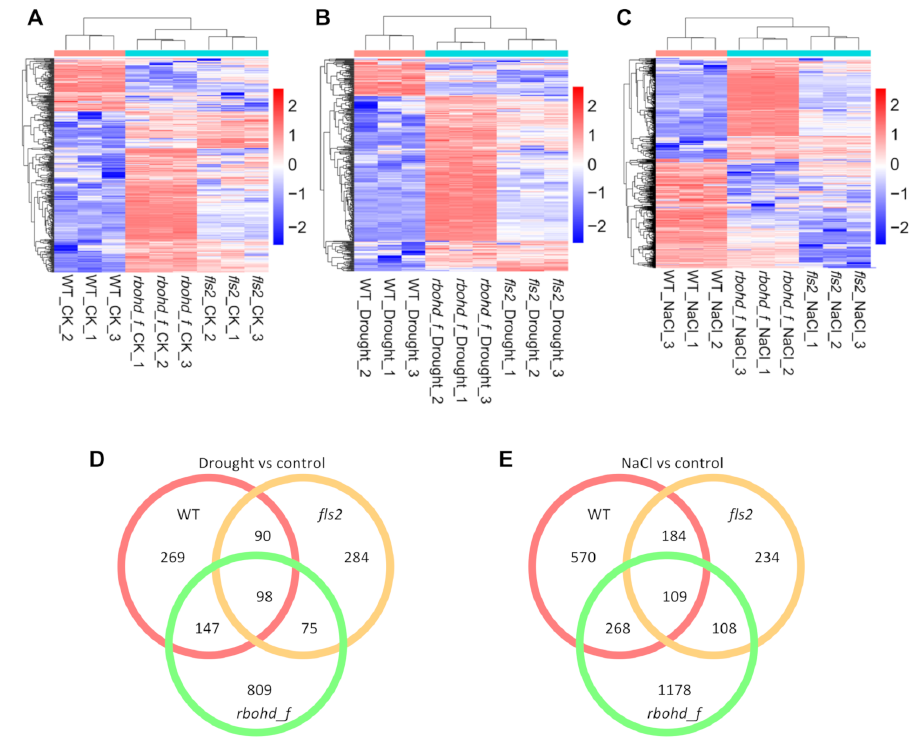
Figure 2. Heatmap and Venn analysis of DEGs under drought and salt conditions. ( A – C ) The heatmap analysis of the expression of DEGs. The number of suffix of sample name represents 1–3 repetitions. The screening criteria were fold change > 2 and p -value < 0.05. Red indicates gene up-regulation, blue indicates gene downregulation, and color depth indicates the degree of difference. ( D , E ) The Venn analysis compares the co-regulatory number of DEGs under drought and salt treatment with that of